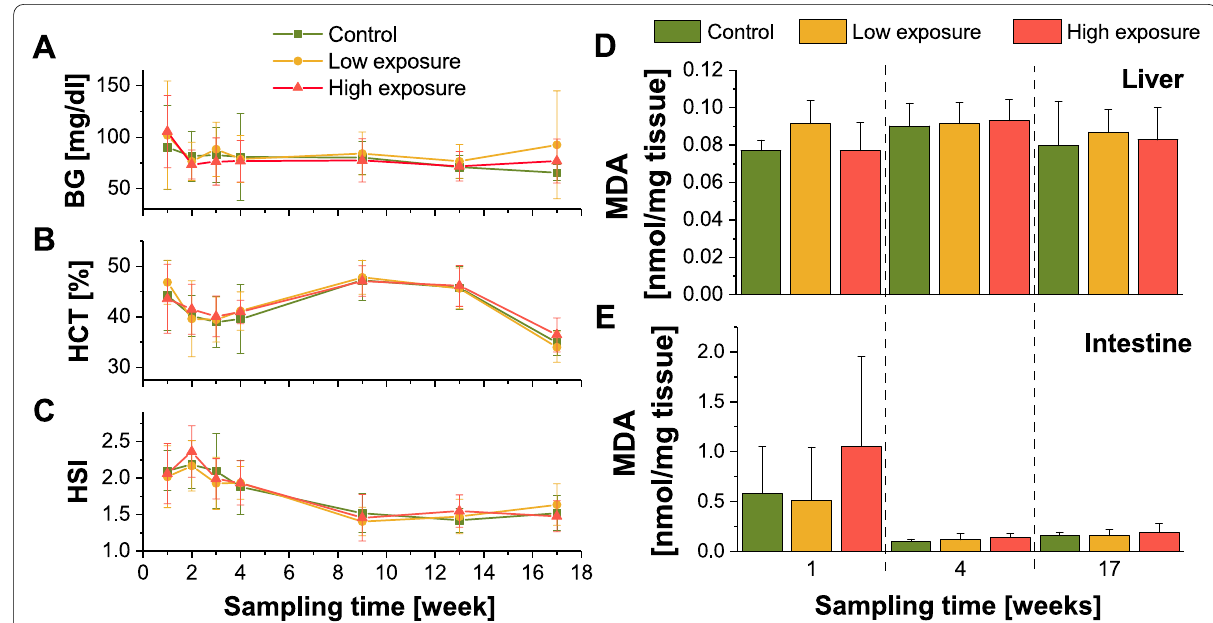
Fig. 4 Health parameters of rainbow trout for each treatment in the exposure experiment. (A) Mean blood glucose concentration ( sampling. (B) Mean haematocrit levels ( SD) for each sampling. (C) Mean hepatosomatic index ( ± the TBARS Assay for three time points. The mean malondialdehyde (MDA) concentration ( significant differences, please refer to Table